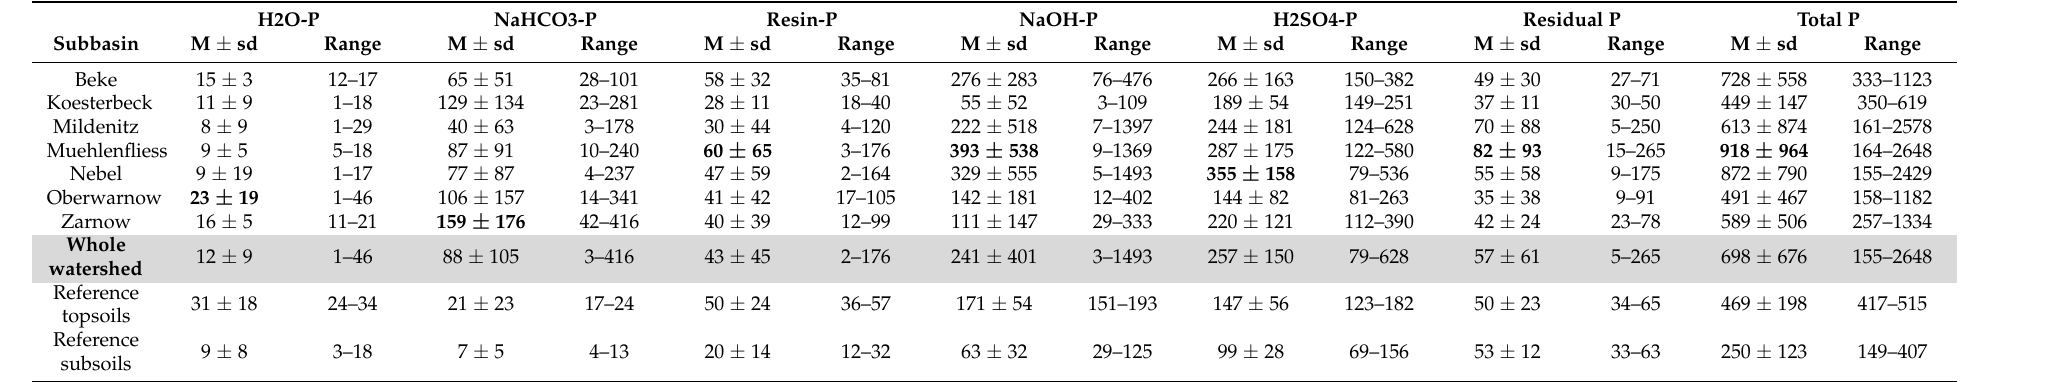
Table 1. Mean and standard deviation (M ± sd), maximum and minimum (range) values of P contents using the sequential Hedley fractionation (0–2 cm sediment) for all sub-basins and the whole watershed. All data are given in mg P kg − 1 sediment − 1 . Bold numbers indicate the maximum values in each